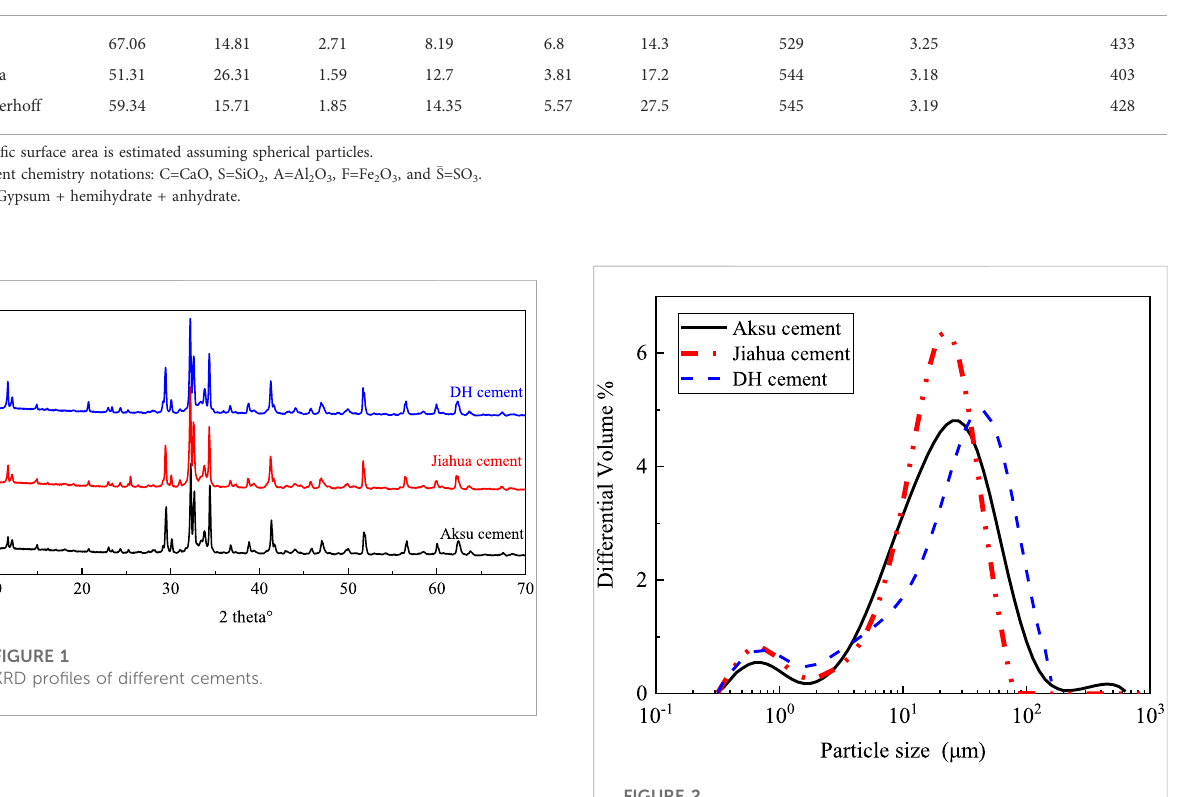
FIGURE 2 Particle size distribution of different